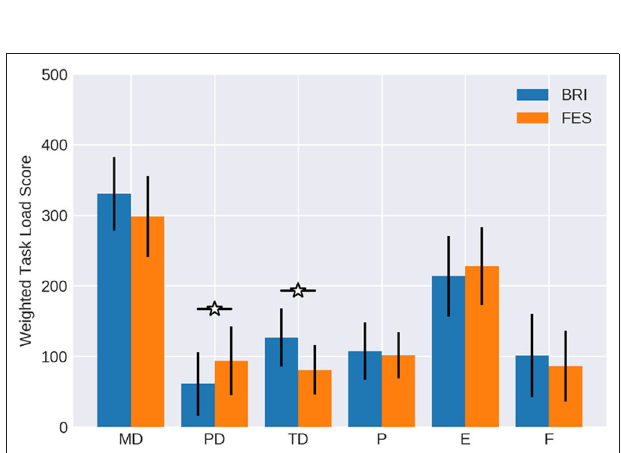
FIGURE 5 | Weighted workload scores. The importance weight ( Figure 3 ) of each workload component was multiplied with the respective magnitude ( Figure 4 ) and averaged over all subjects. Confidence intervals are given with a probability of